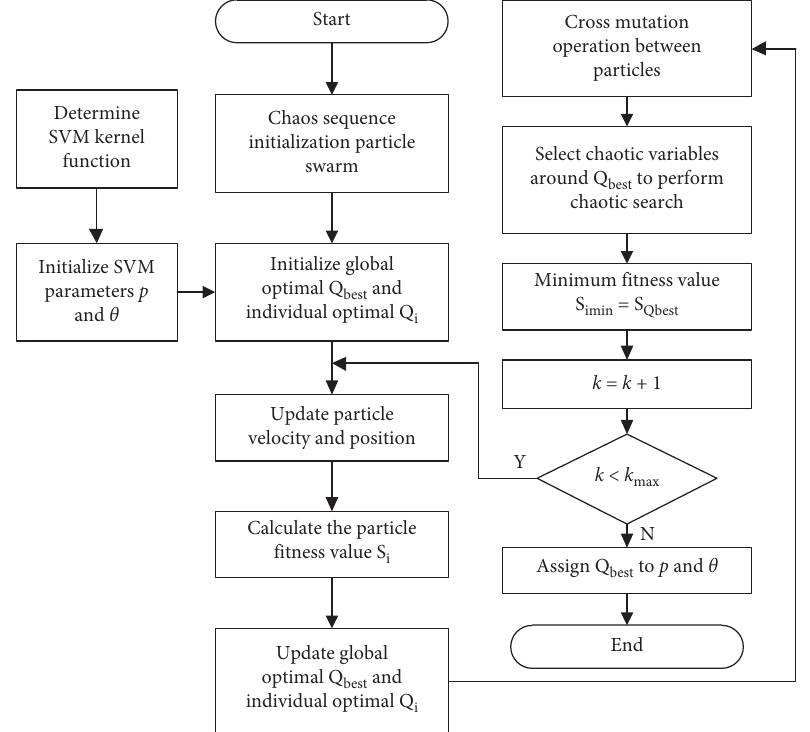
Figure 1: The process of SVM optimized by